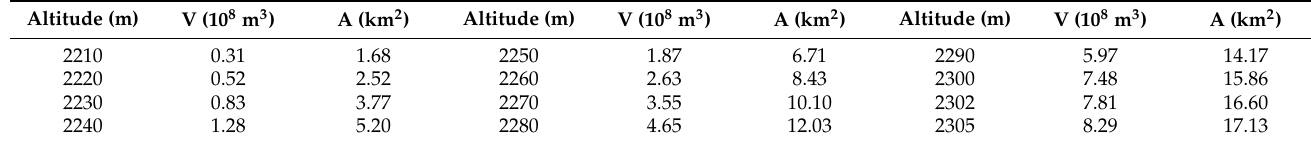
Table 1. Xulong Reservoir information.